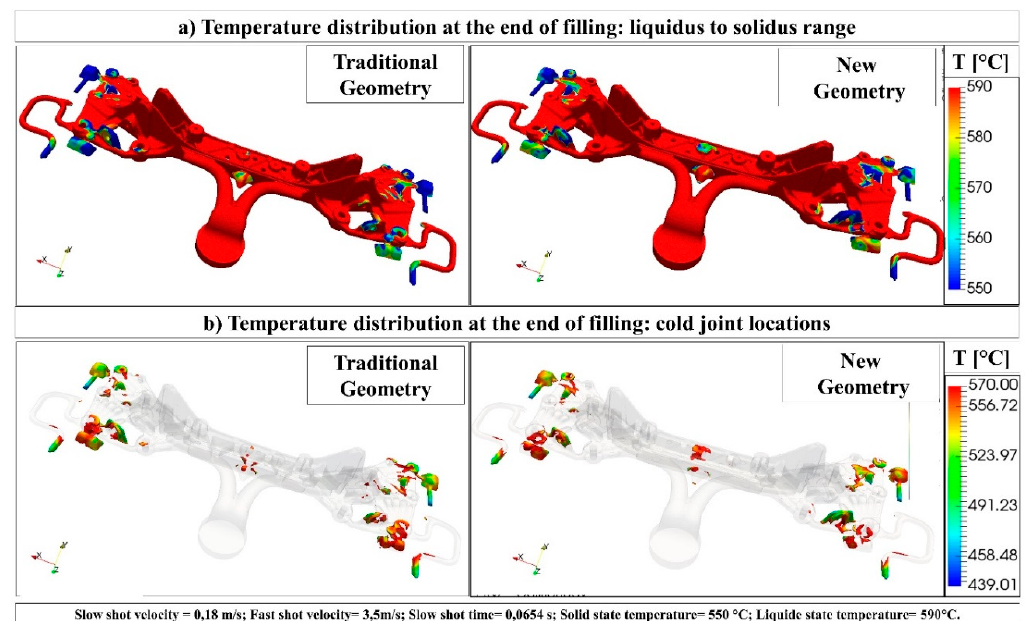
Figure 10. ( a ) Temperature distribution at the end of filling: liquidus to solidus range; ( b ) Temperature distribution at the end of filling: cold joint locations.